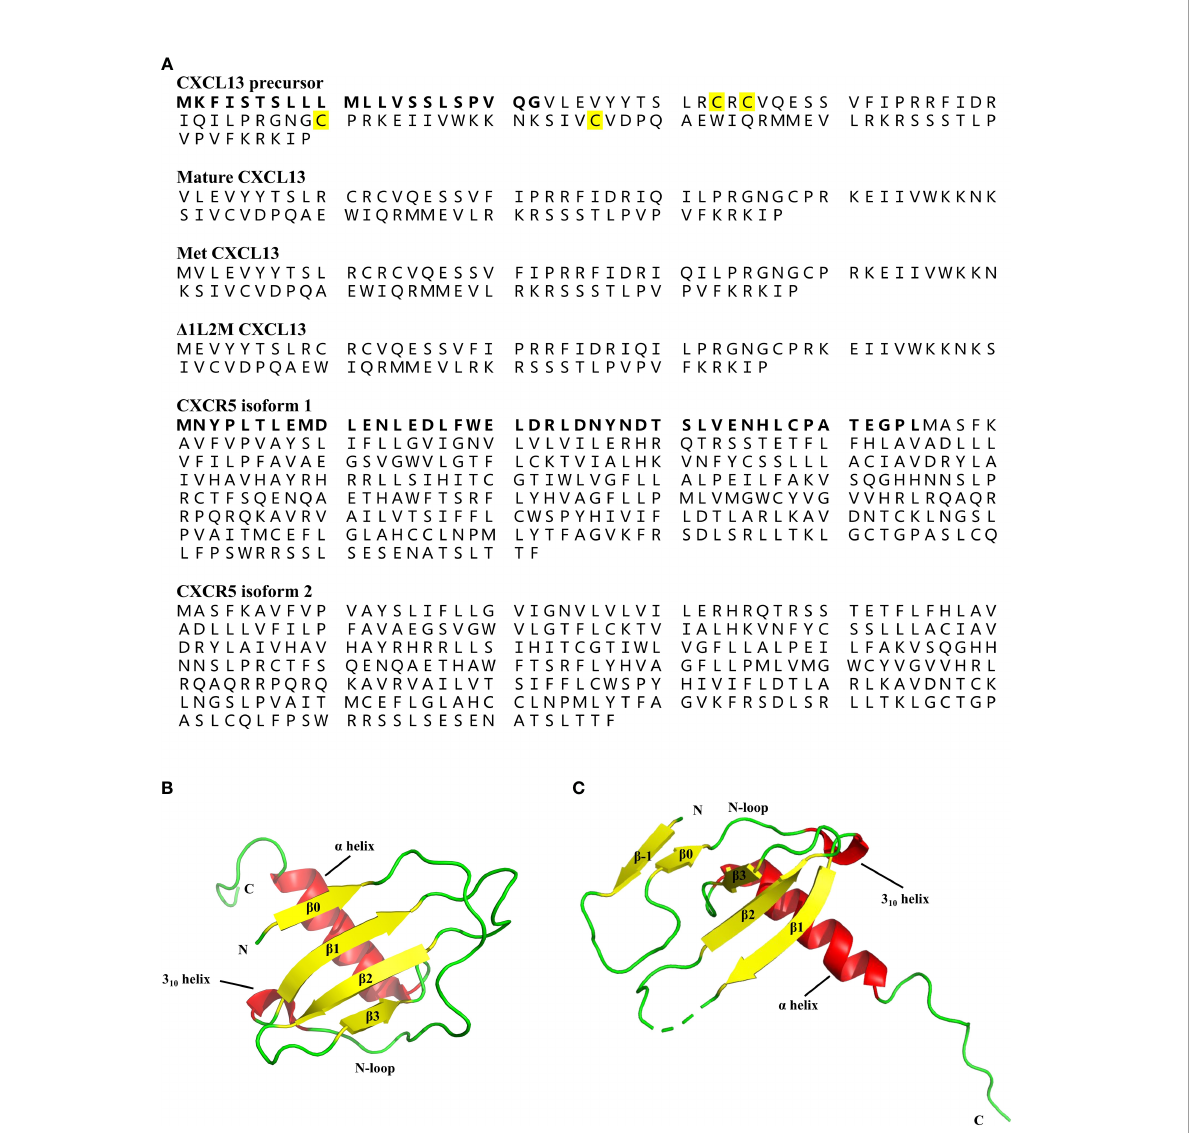
FIGURE 3 Protein structures of CXCL13 and CXCR5. (A) The amino acid sequence of human CXCL13 precursor, mature CXCL13, Met CXCL13, D 1L2M CXCL13, and two isoforms of human CXCR5. The human CXCL13 protein consists of 109 amino acids, including a signal peptide of 22 amino acids (marked in bold). The four conserved cysteine residues are marked in yellow. The human CXCR5 has two isoforms due to the alternatively spliced transcript variants. The difference between the two isoform of CXCR5 is additionally marked in bold. (B) The tertiary structure of Met CXCL13 [Protein Data Bank (PDB) ID: 7JNY]. The N-terminus of Met CXCL13 forms a b 0-sheet, followed by a long N-loop ending in a short 3 10 - helix, and the central three-stranded anti-parallel b -sheet, and a C-terminal a -helix. b -sheet is indicated by yellow arrows, and a -helix and 3 10 - helix are indicated by red cylinders. (C) The tertiary structure of D 1L2M CXCL13 monomer [PDB ID: 6VGJ]. In D 1L2M CXCL13, the N-terminus folds into a b -strand ( b -1), followed by a b 0-sheet, and a canonical chemokine core domain. b -sheet is indicated by yellow arrows, and a -helix and 3 10 -helix are indicated by red